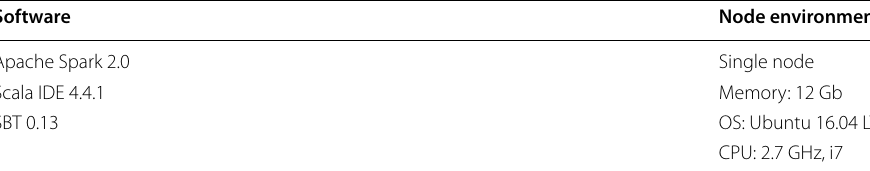
Table 4 Experiment environment